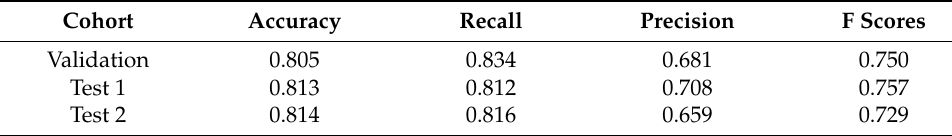
Table 2. Model parameters from the validation and test cohorts.